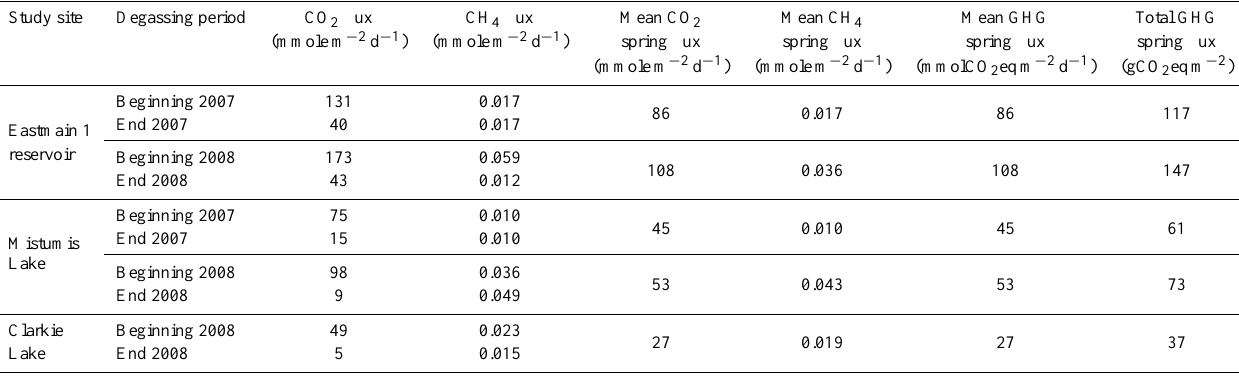
Table 5. Spring CO 2 , CH 4 and GHG flux. The beginning and end of the degassing periods are assumed to be around 15 May and 15 June, respectively.